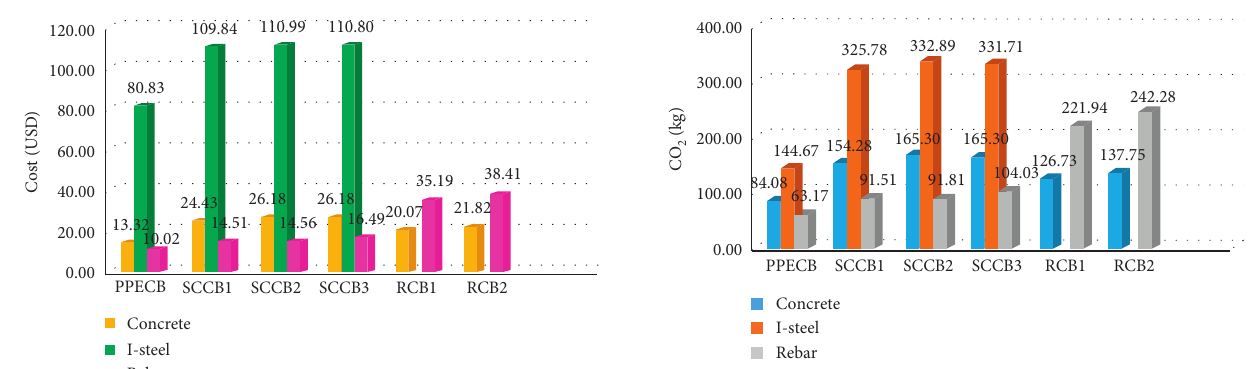
Figure 13: CO 2 emission from materials of different